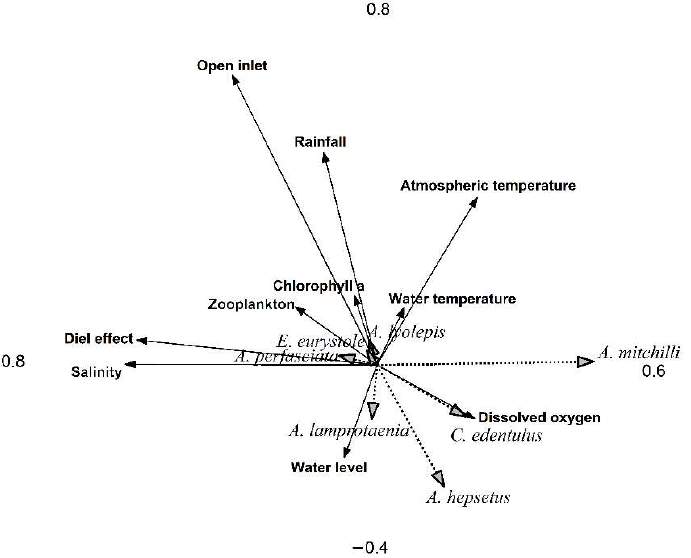
Figure 4. RDA biplot of species (dotted line vectors) and environmental variables (solid line vec- tors). Length and direction of arrows indicate the relative importance and direction of change of environmental variables.